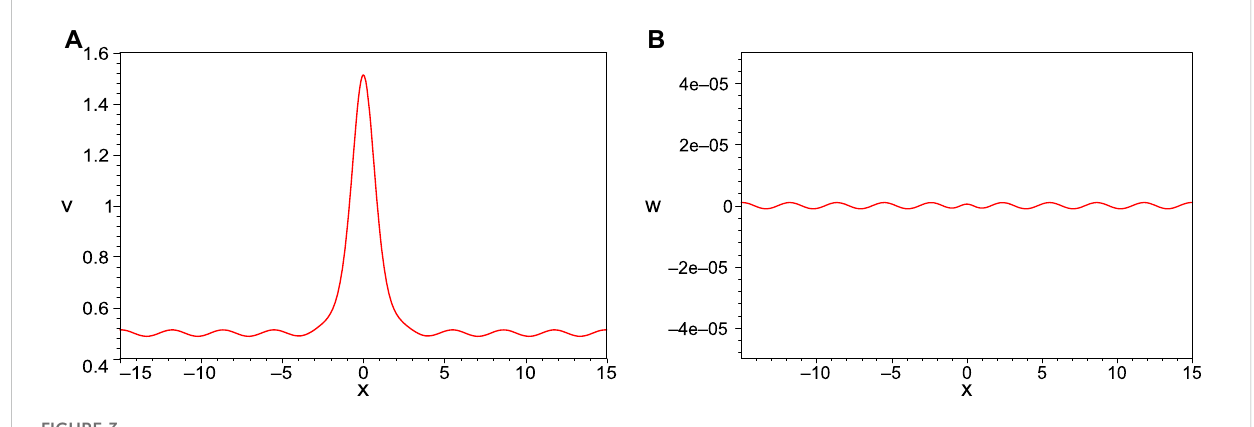
FIGURE 3 2D plots of the soliton-cnoidal periodic wave interaction solutions (A) v and (B) w with m = 0.00001, and other parameters are chosen as those in Figure